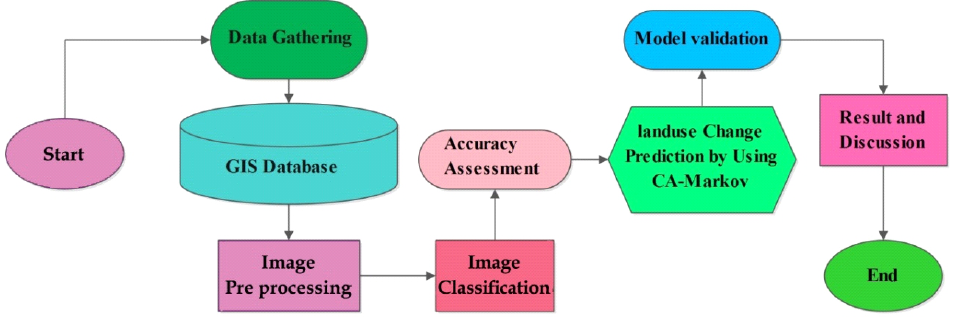
Fig. 2: The research methodology as a flowchart